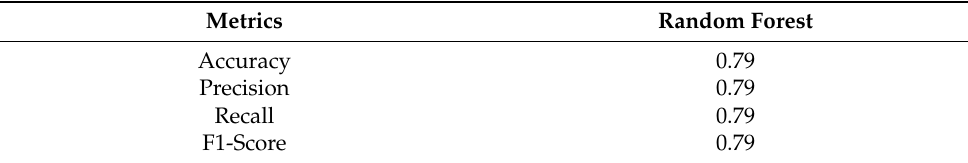
Table 1. Evaluation with RF Classifier.